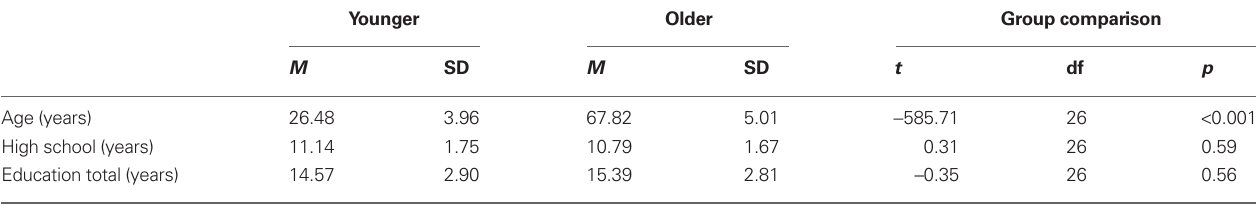
Table 1 | Sample description. Age and years of formal education of younger and older adults are displayed.